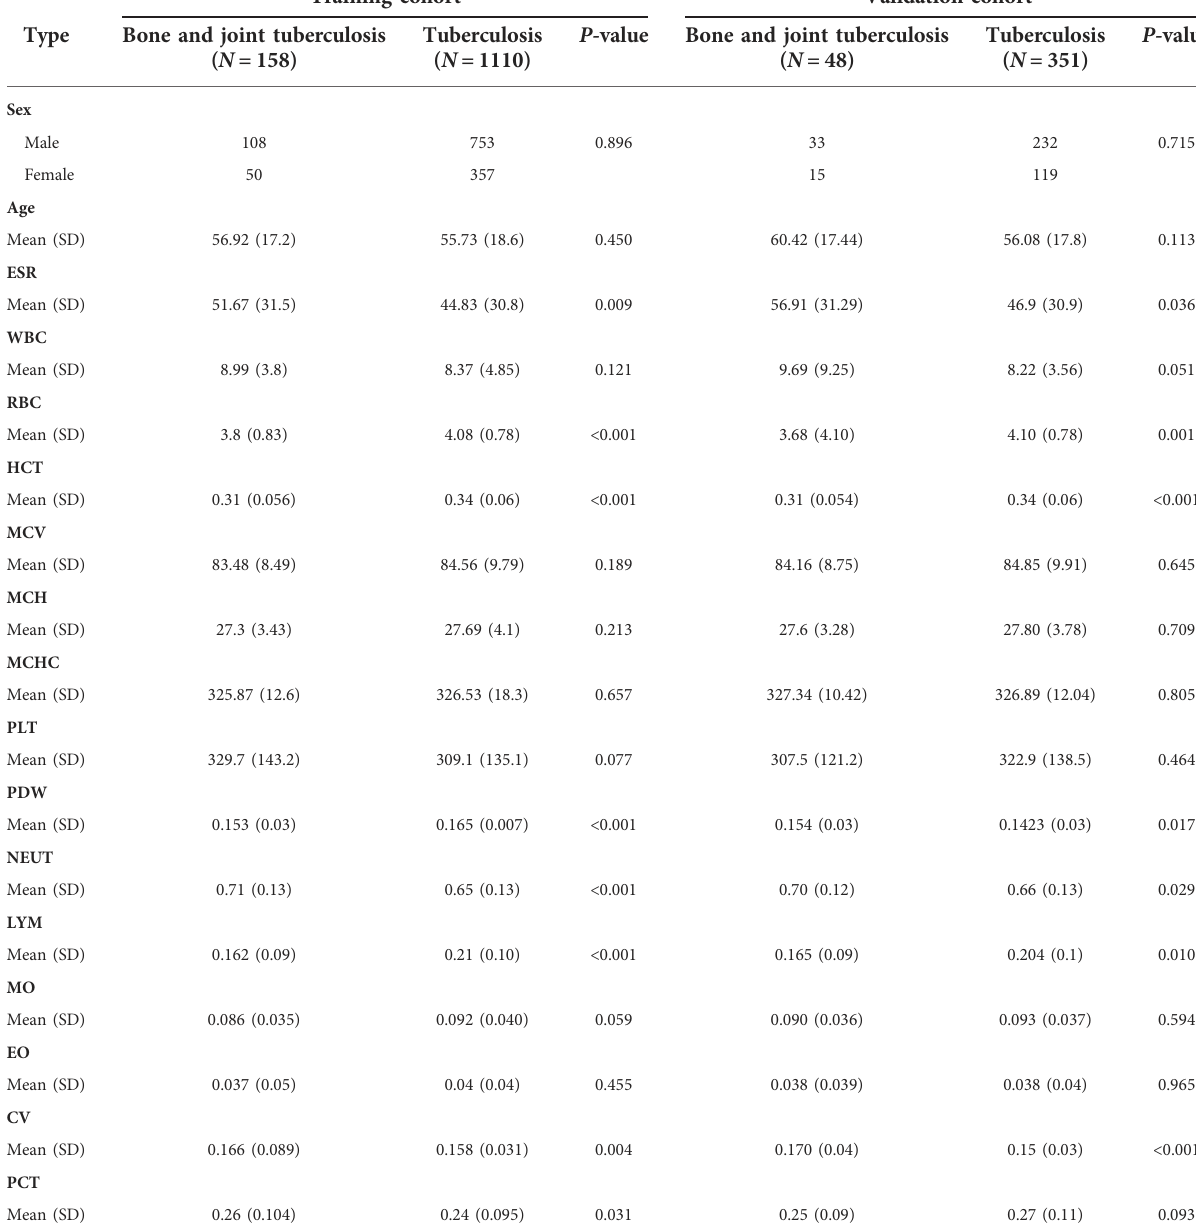
TABLE 1 The differences ESR and blood routine